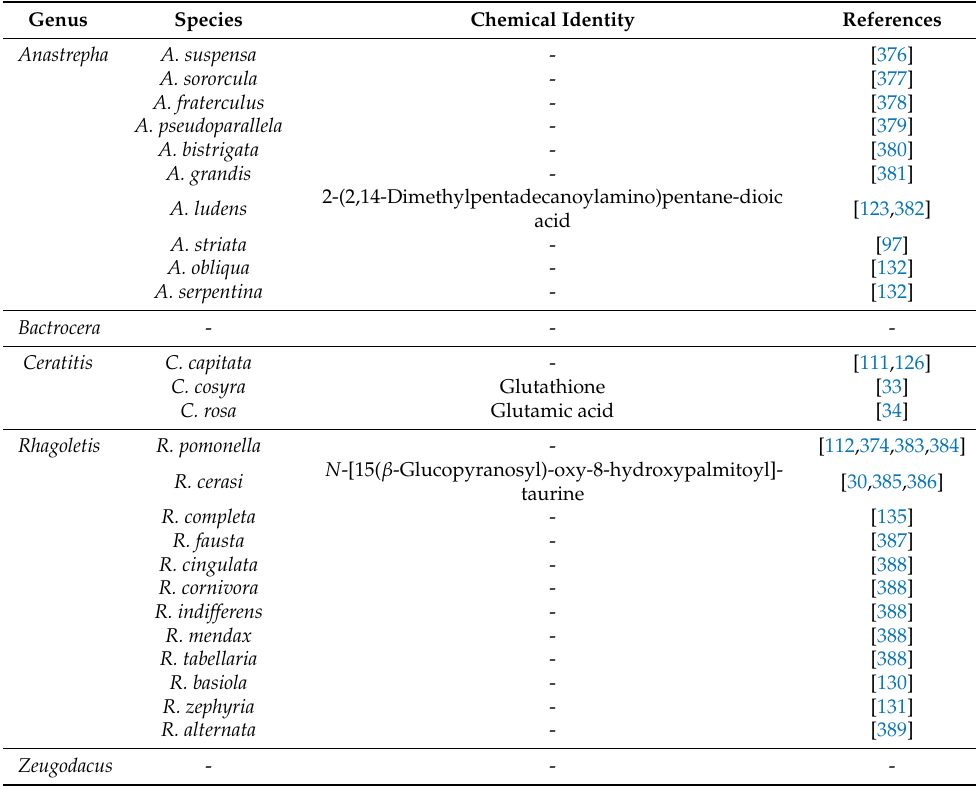
Table 3. List of tephritid species for which host-marking behaviour has been identified.